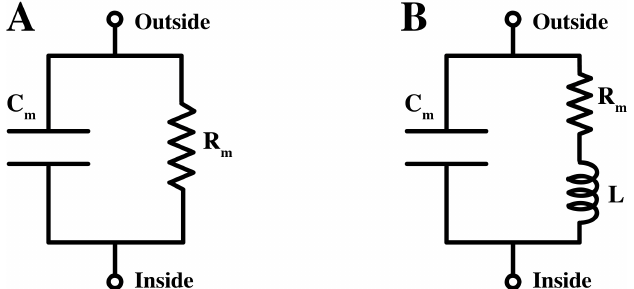
Figure 1. ( A ).The equivalent circuit of the lipid membrane, containing a resistor (Rm) and a capacitor (Cm) in parallel. ( B ). An approximate equivalent circuit for the membrane of the squid giant axon with additional inductance,